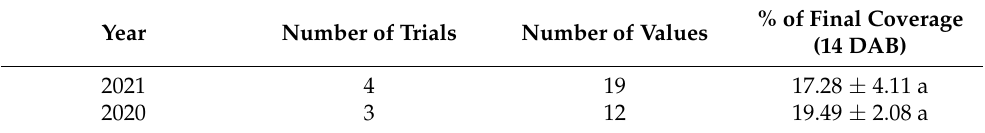
Table 10. Results of final coverage in seven trials; 3 carried out in 2020 and 4 in